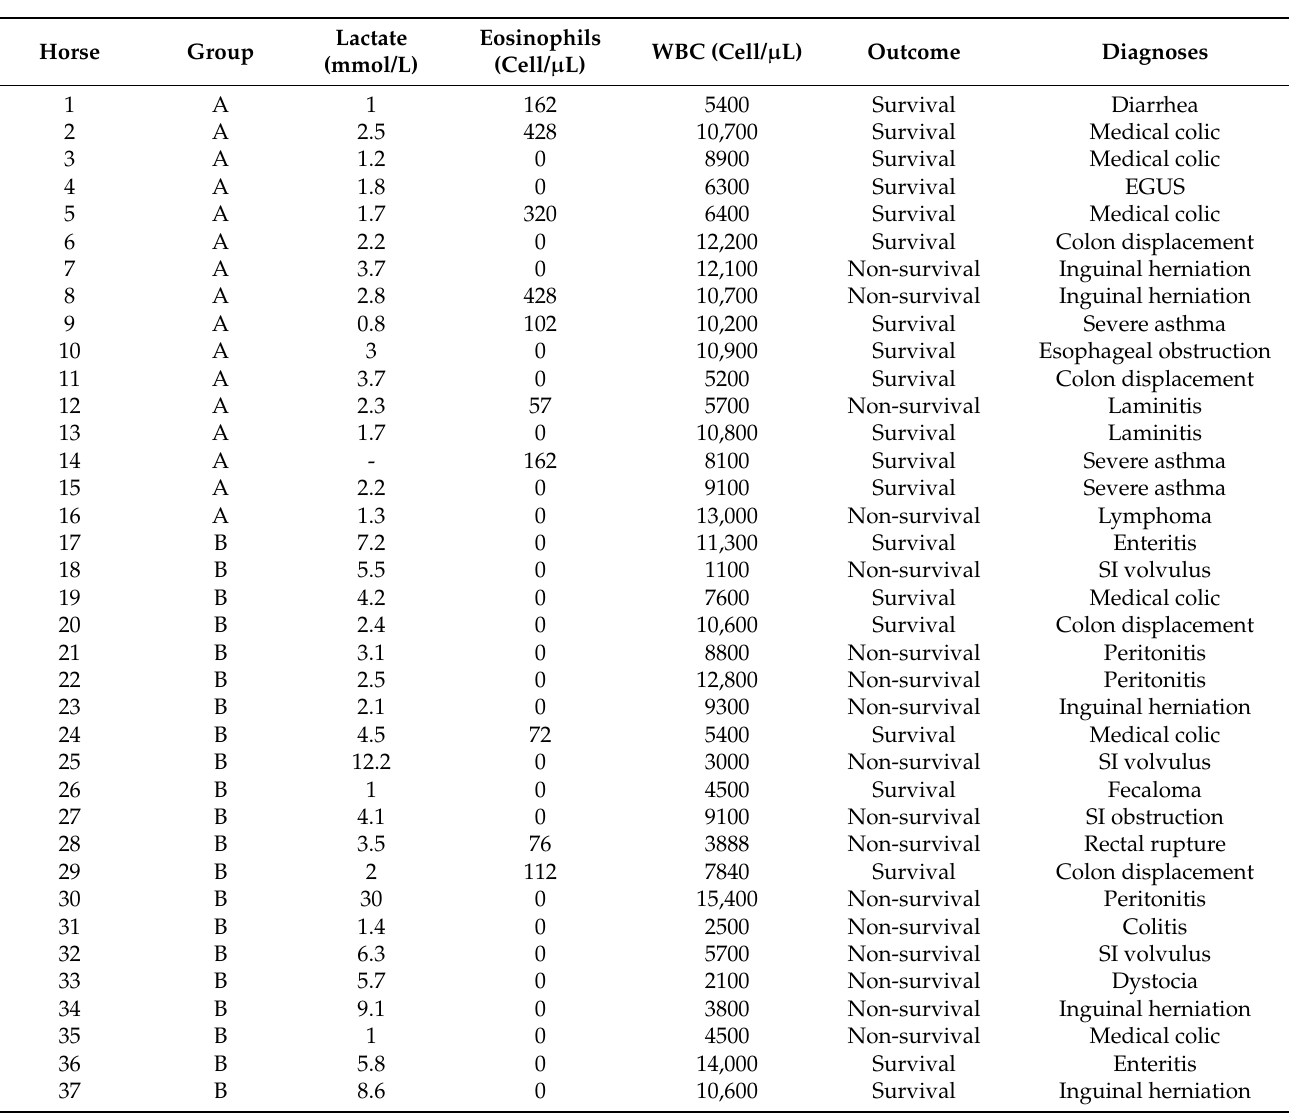
Table 1. Demographics and laboratory data of horses on admission. The diagnosis and outcome of each patient is reported (Groups A and